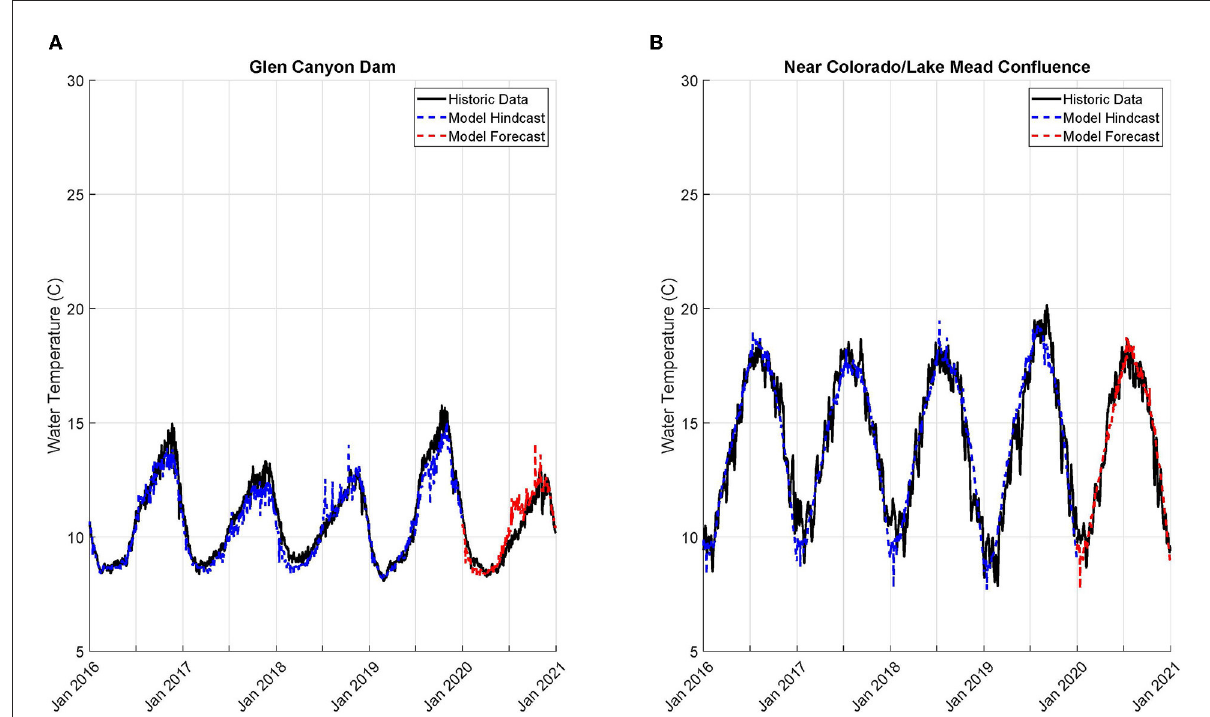
FIGURE5 Hindcast and forecast for temperature model located at (A) GCD; and (B) downstream Diamond Creek.